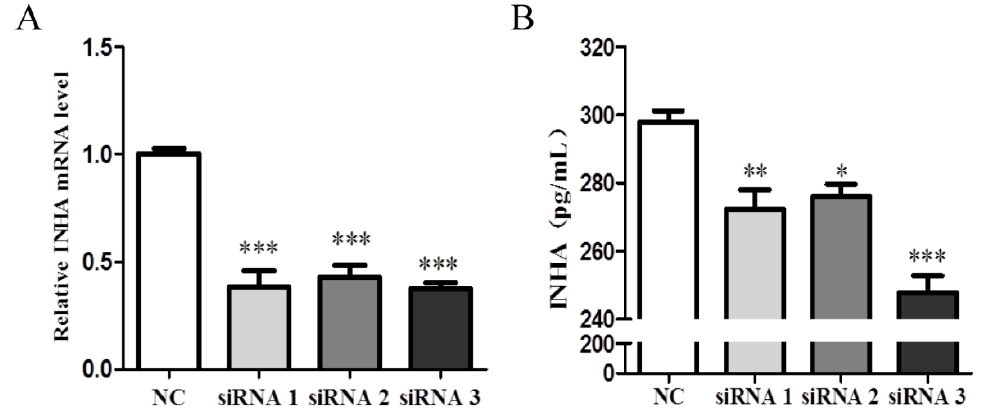
Figure 4. The interference e ffi ciency of INHA siRNA. ( A ) Cells were treated with a negative control (NC) siRNA or INHA siRNA. After 24 h, RT-qPCR was used to measure INHA mRNA expression (n = 3). ( B ) ELISA was also used to measure INHA levels (n = 3). *** P < 0.001; ** P < 0.01; * P < 0.05.